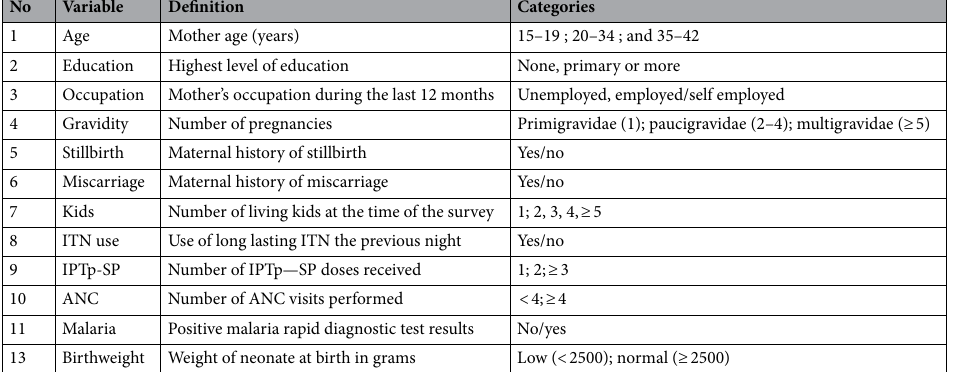
Table 1. List of exploratory variables. ANC antenatal care, ITN insecticide treated bed net, IPTp-SP intermittent preventive treatment of malaria with